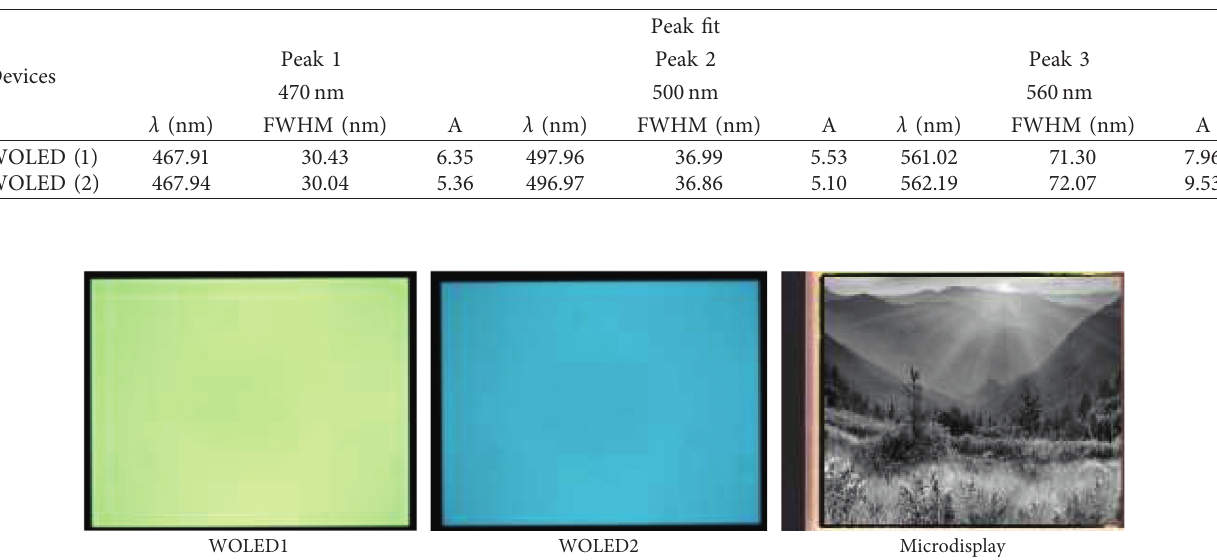
Figure 7: White OLED microdisplay